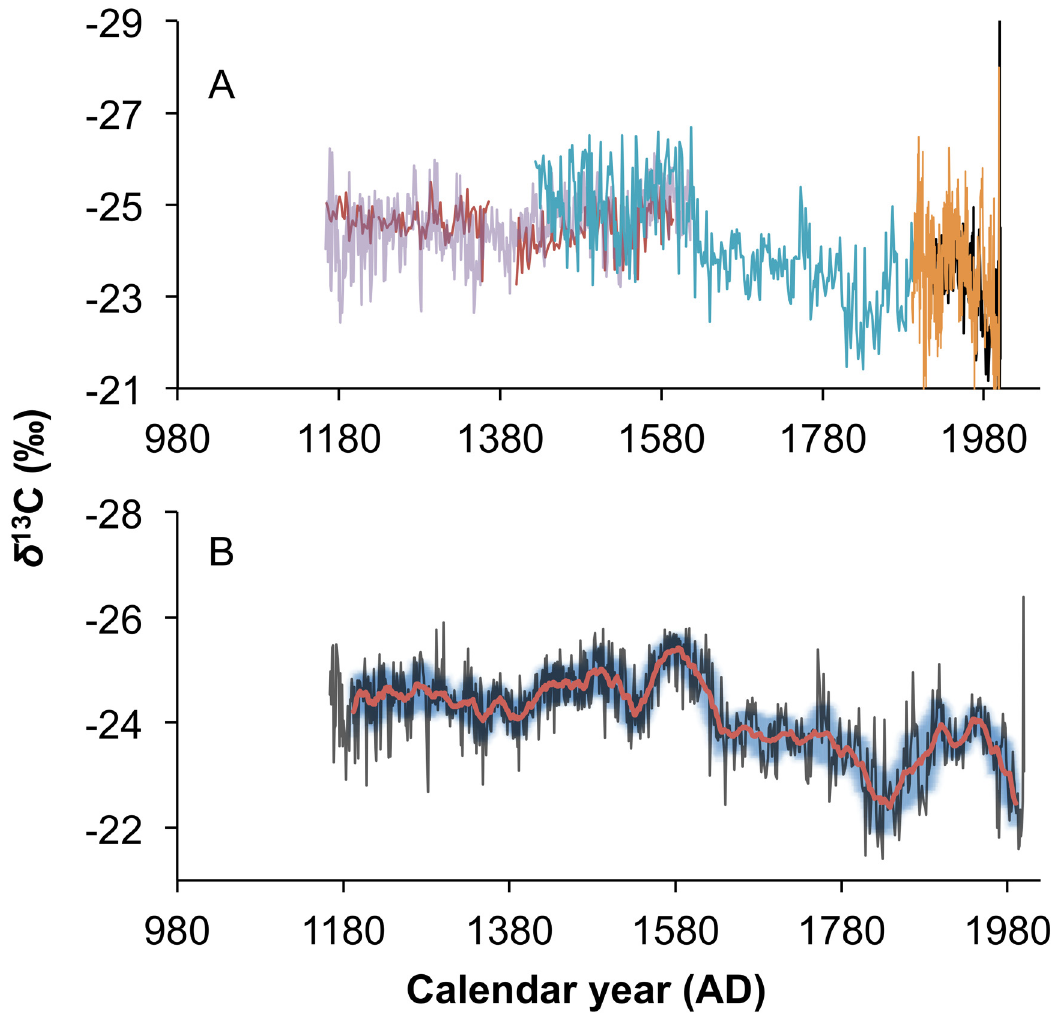
Fig 3. The baobab δ 13 C record from Mapungubwe. (A) The isotopic record from individual trees from Mapungubwe: LKA (purple), LKB (blue), Luna (red), MPC (orange) and Schroda (black). (B) The record from the 5 baobabs in the in the Mapungubwe sample are averaged (black) and the 21-year biweight mean (red) is calculated. The blue shading portrays the 21-year biweight mean variance.